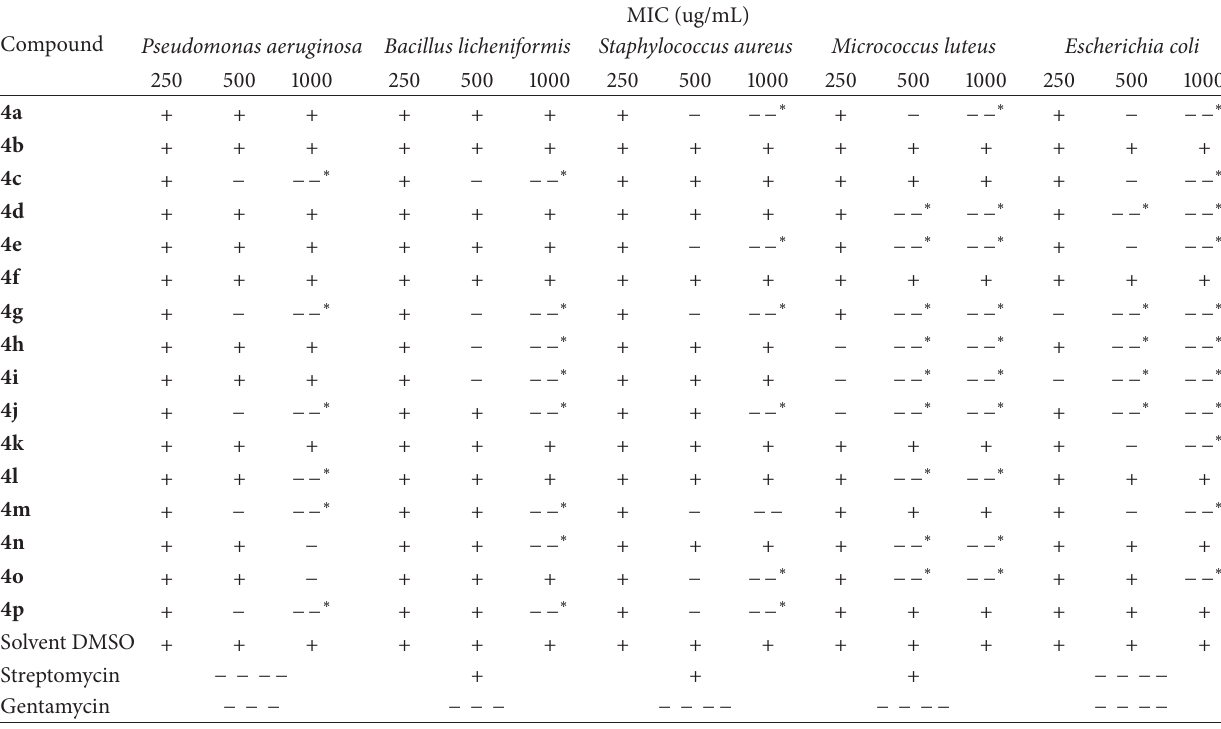
Table 4: Minimum inhibitory concentration for